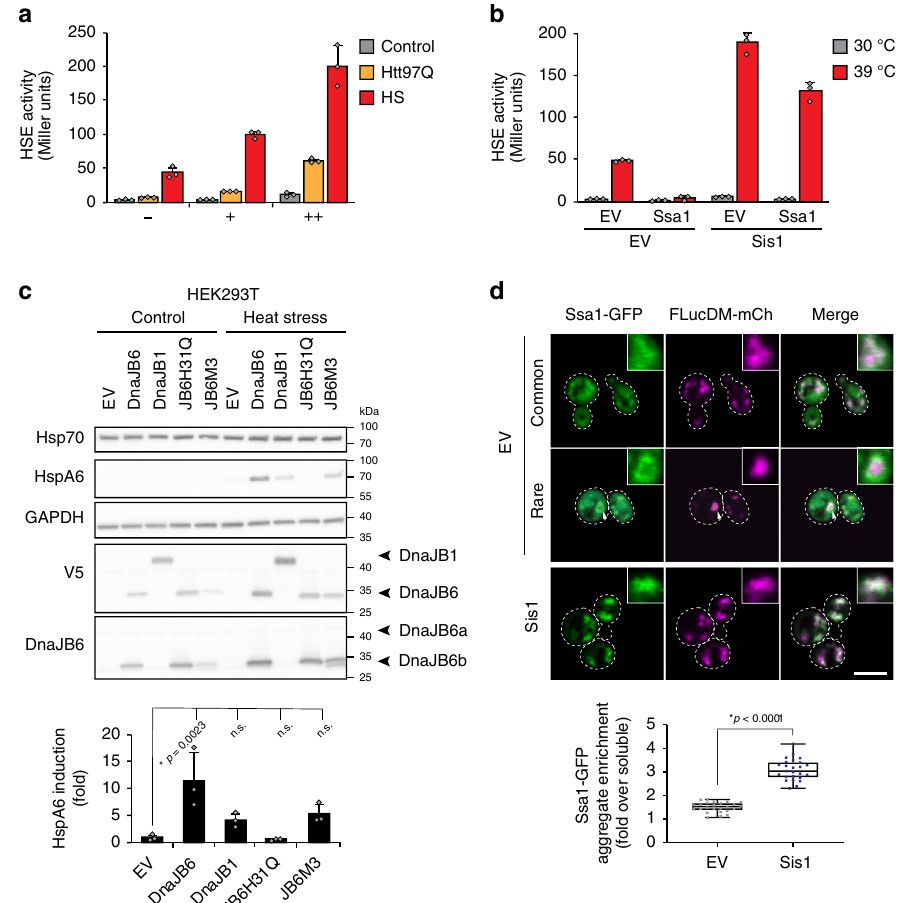
Fig. 6 Sis1/DnaJB6 potentiates the cytosolic stress response. a Sis1 enhances the HSR in yeast. P HSE LacZ activity was measured in cells expressing Sis1 at endogenous (EV, − ), mildly elevated (P CYC Sis1, + ), or highly elevated (P GPD Sis1, ++ ) levels at 30 °C (gray bars) or after a mild heat stress of 1 h at 37 °C (red bars). Cells co-expressing Htt97Q at 30 °C were analyzed for comparison (orange bars). Data represent mean + SD from three independent experiments. b Ssa1 co-overexpression does not repress HSR enhancement in Sis1 overexpressing cells. P HSE LacZ activity was measured in cells with or without Sis1 overexpression and with or without co-overexpression of Ssa1 at 30 °C (gray bars) or after a mild heat stress of 1 h at 39 °C (red bars). Data represent mean + SD from three independent experiments. c DnaJB6 potentiates the HSR in mammalian cell culture. Lysates from HEK293T cells transfected with a vector control, DnaJB6, DnaJB1, or DnaJB6 mutants H31Q, defective in interaction with Hsp70, or M3, which contains mutations within the unstructured S/T rich region were analyzed by SDS-PAGE and immunoblotting for the indicated proteins. Cells were grown at 37 °C and either maintained at 37 °C (Control) or exposed to heat stress for 1 h at 43 °C and recovery (Heat stress). Representative blots of three independent experiments are shown. Data represent mean + SD for three independent experiments. * p values were calculated by Dunnett ’ s multiple comparisons t -test to EV control. n.s. not statistically signi fi cant. d Co-localization of Ssa1 with FlucDM aggregates. Confocal microscopy was performed on cells containing a copy of SSA1-GFP under the ADH promoter and expressing FlucDM with or without Sis1 co-overexpression grown at 30 °C and incubated at 37 °C for 1 h. Representative images are shown. Arrow indicates example of rare ringed aggregate. Scale bars = 5 μ m. Ratios of Ssa1-GFP in aggregates vs. soluble are quanti fi ed. Box plots represent median and 25th and 75th percentile, and whiskers minimal and maximal values. n = 25 cells. p value was calculated by unpaired, two-sided t